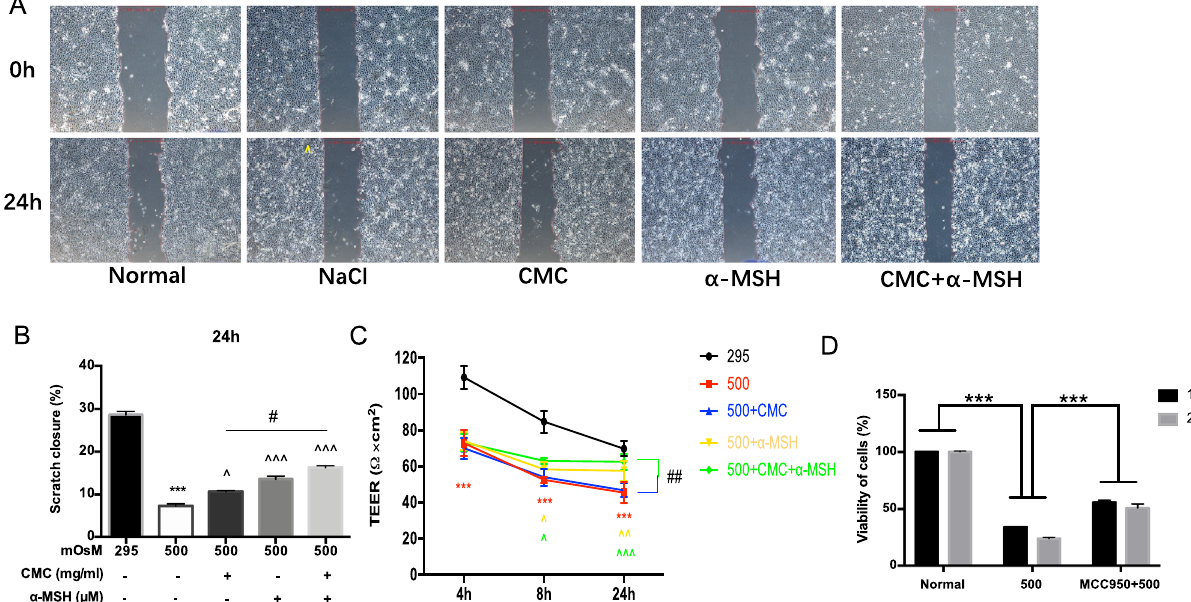
Figure 5. Combined CMC + α-MSH treatment promoted migration and tight junction formation by HCECs exposed to hyperosmotic environmental stress. Representative images immediately after and at 24 h after scratch formation are shown ( A ). The migration ratio was quantified ( B ). The resistance value between upper and lower chambers represented the tight junction ability of HCECs ( C ). The HCEC viability was measured by CCK assay after treatment in sodium medium and MCC950. Three independent experiments were performed ( D ). Data are shown as mean ± SEM, n = 6 per